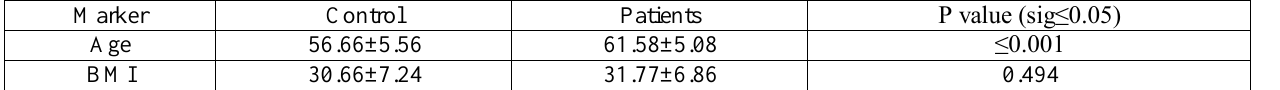
Table 1: Age and body mass index of patients and control groups.